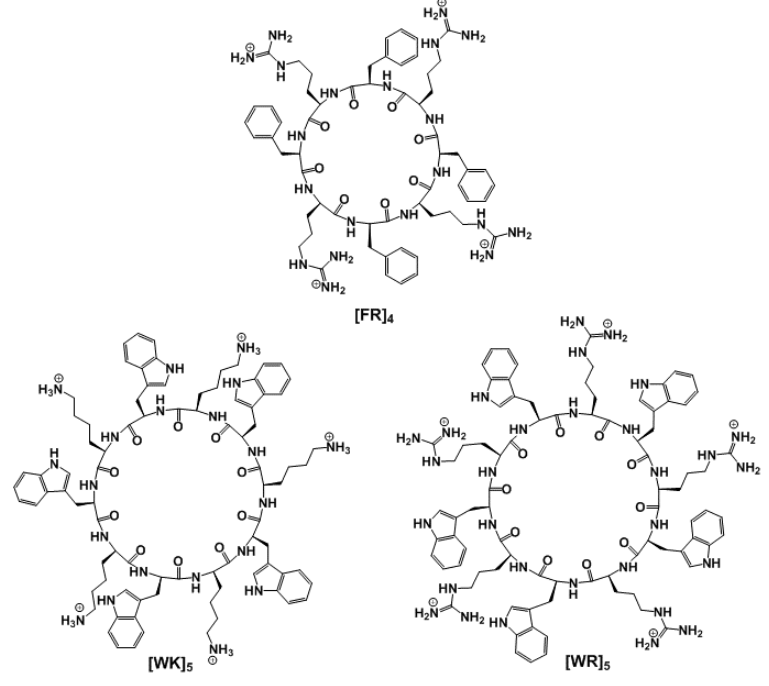
Figure 1. Cyclic peptides containing hydrophobic and positively-charged residues.